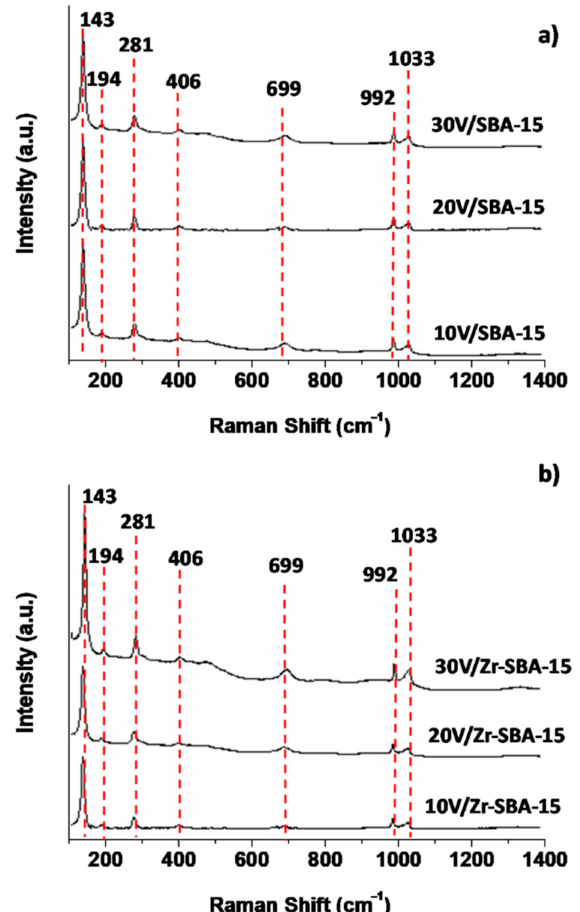
Figure 6. Raman spectra. ( a ) V 2 O 5 /SBA-15; ( b ) V 2 O 5 /Zr-SBA-15.